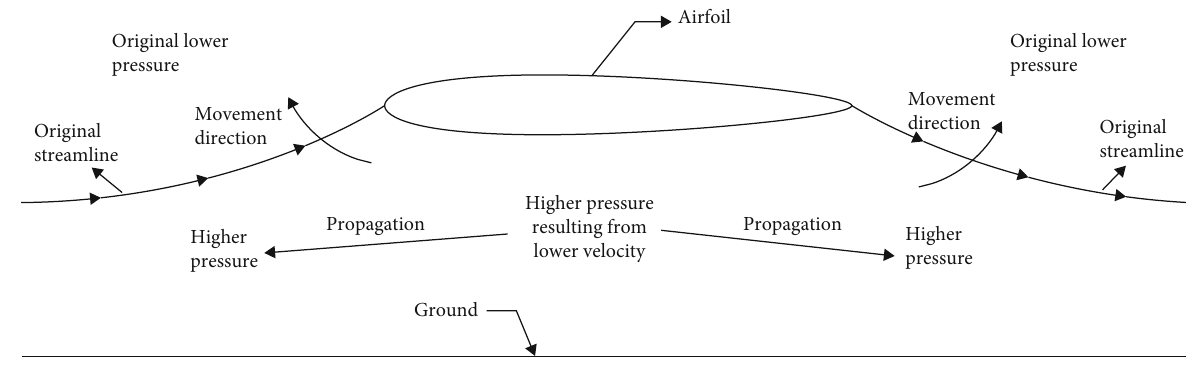
Figure 21: Principle of streamline de fl ection for upper slot blowing with C